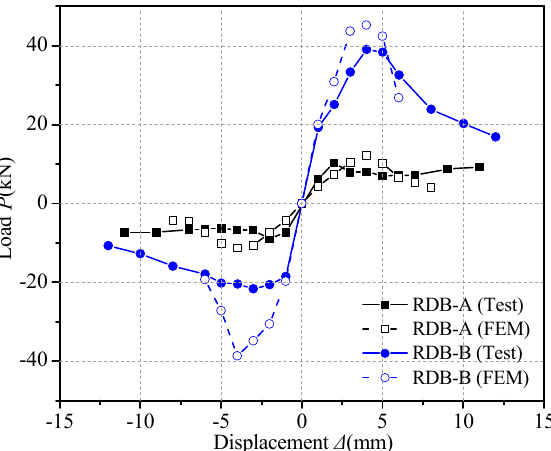
Figure 11. Comparison of the load-displacement relationship between the test and FEM results.